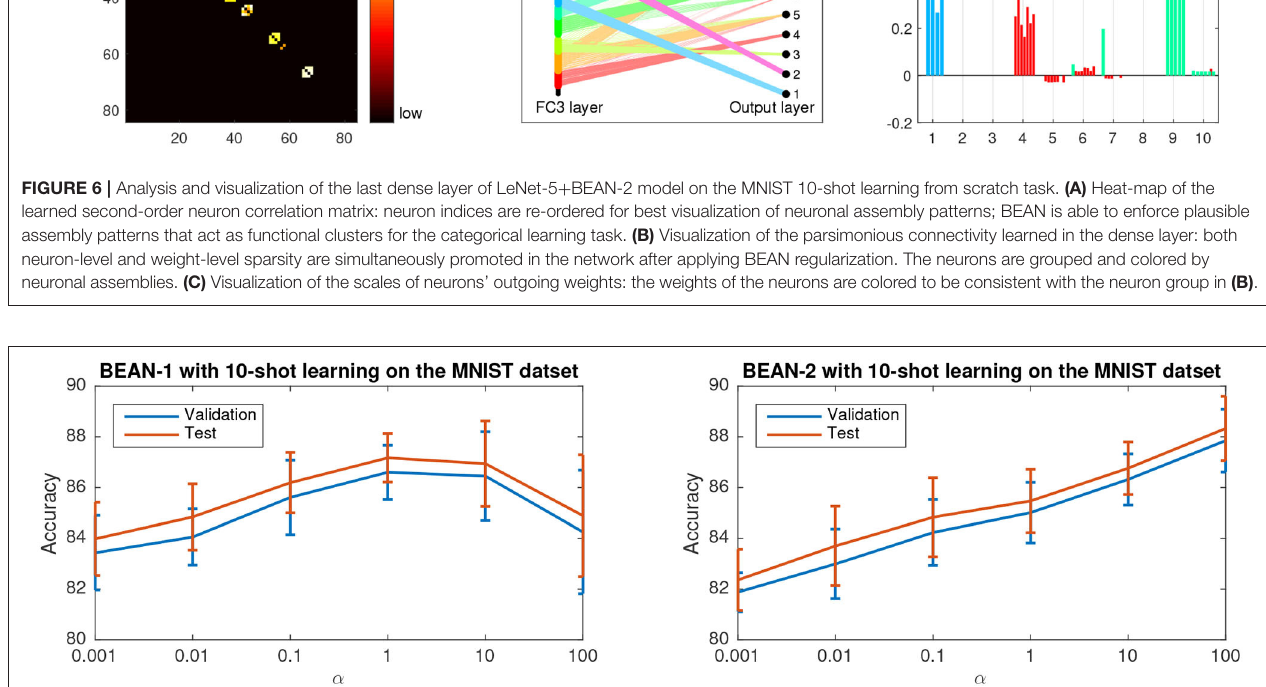
the state-of-the-art by a significant margin on all four few- shot learning from scratch tasks tested among all three